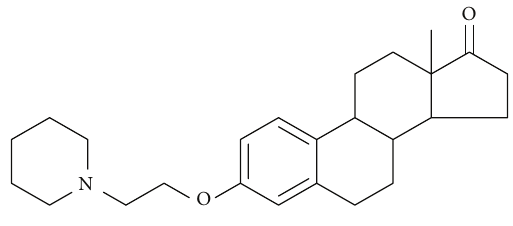
Figure 1: Chemical structure of